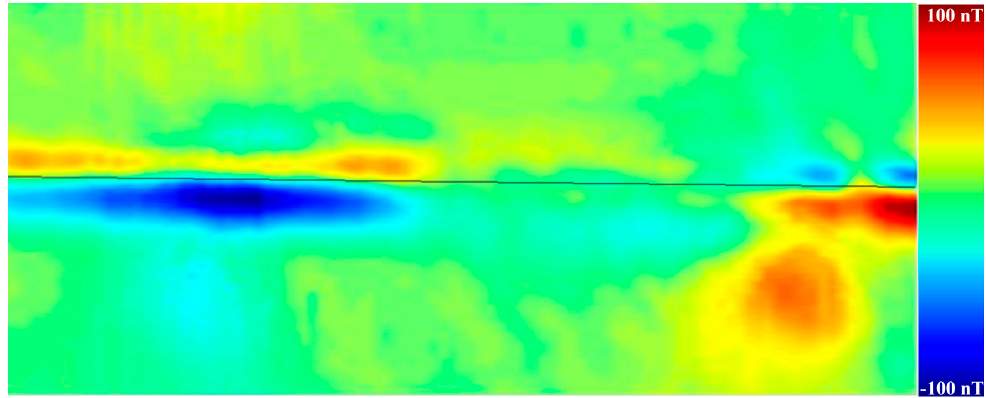
Figure 8. 3D color-scale image of the magnetic field distribution measured over a weld seam (indicated by a black line) made by laser welding. The range of color-scale values is from − 100 nT (blue) to 100 nT (red). The scanned area is 30 mm × 10 mm.